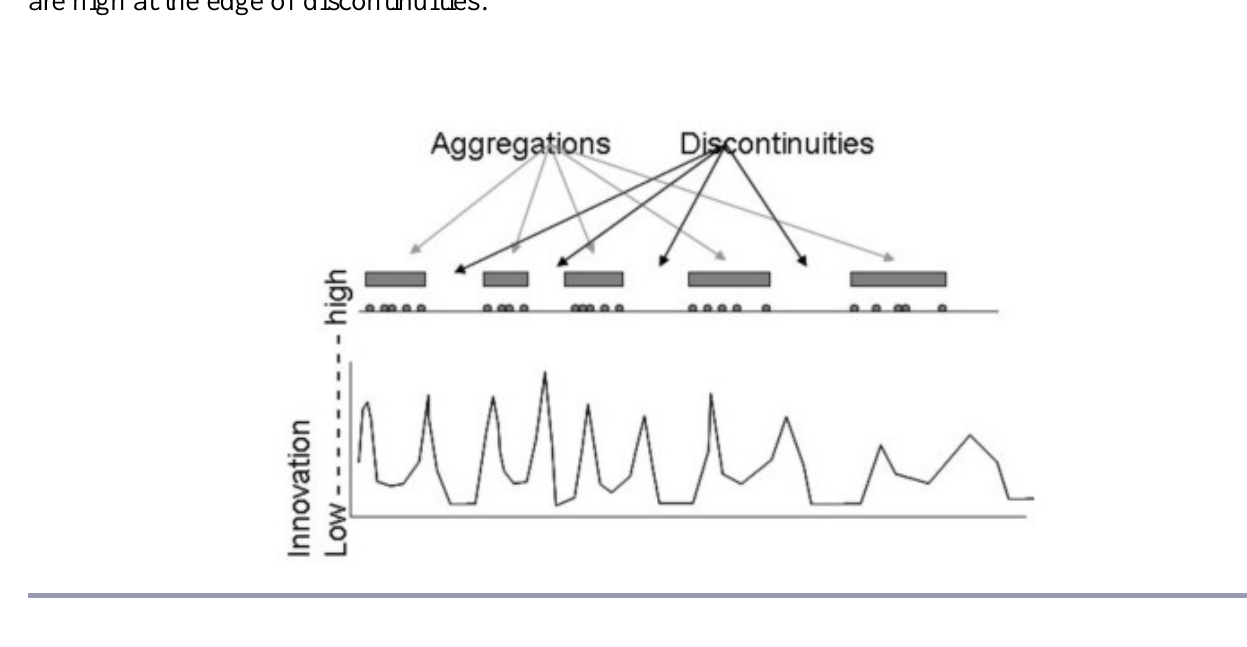
Fig. 5 . Novelty and innovation mirror discontinuities and resource variability in complex systems, and are high at the edge of